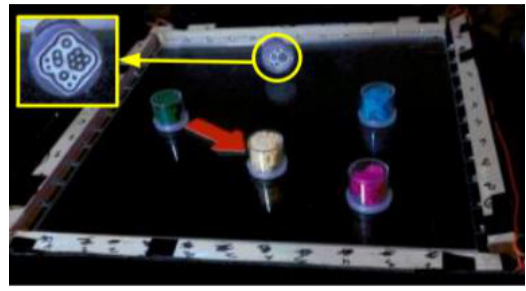
Figure 11. Design of MICOO [26].